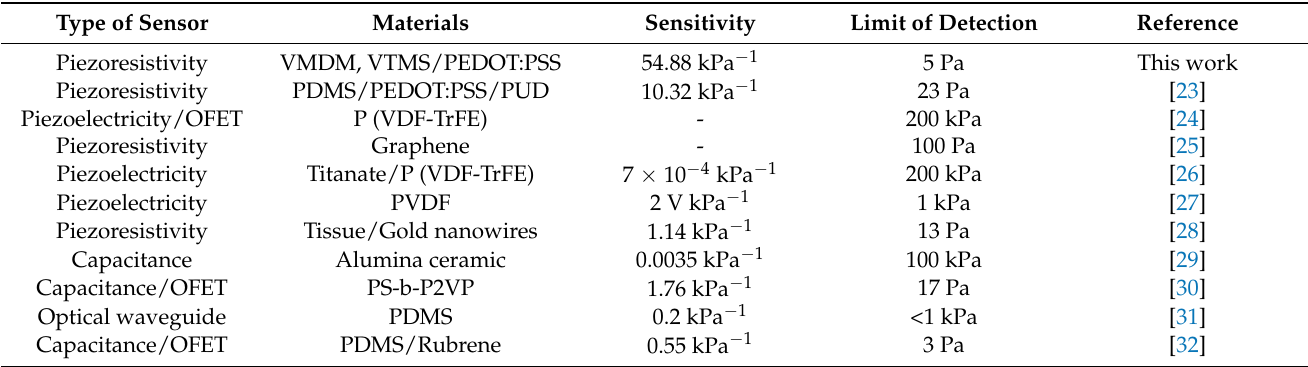
Table 2. Comparison of pressure sensitivity with previously reported pressure sensors (PDMS: polydimethylsiloxane; OFET: organic field effect transistor; PVDF: polyvinylidene